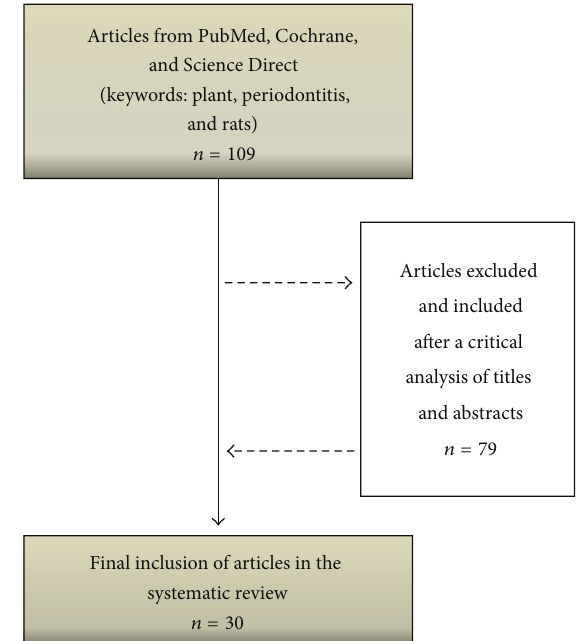
Figure 1: Search flowchart and selection of articles for the review of the